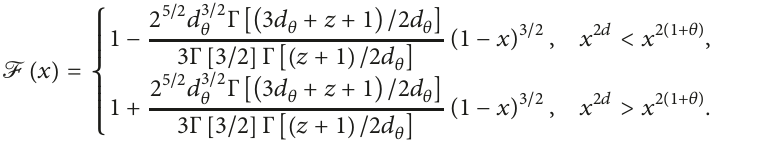
Figure 5: (a) Maximum and (b) average entanglement velocities as a function of 𝑧 . The colors blue, green, orange, and red correspond to 𝑑 = {5, 4,3,2} , respectively, and we have set 𝜃 = 0.1 , 𝑡